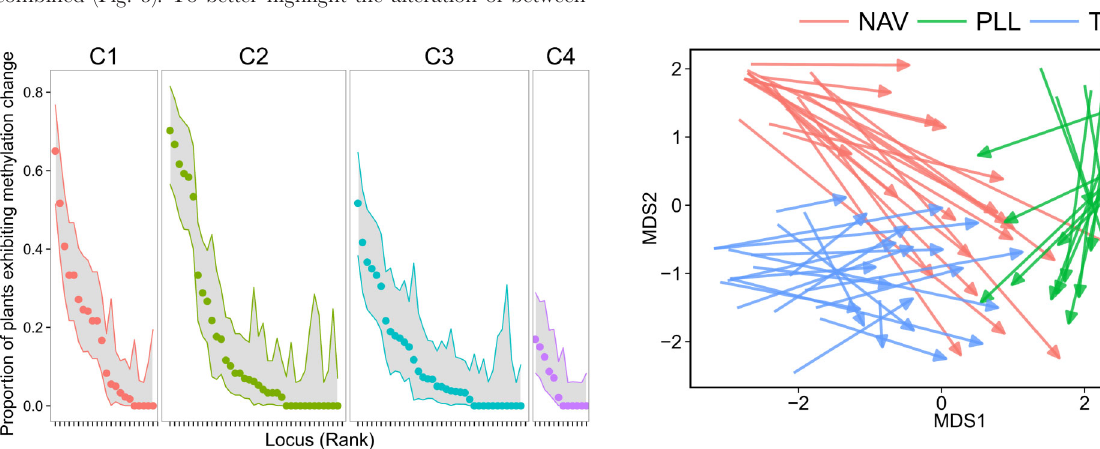
Figure 2. Frequency of DNA methylation changes over the sporophyte-gametophyte transition. Variation among methyla- tion-susceptible loci in degree of instability of methylation status from sporophytes to descendant pollen gametophytes in Helleborus foetidus , expressed as the proportion of individual plants (all sampling sites combined) that exhibited a sporophyte-to-gametophyte methylation change for a given locus. Loci from the four primer combinations used (C1–C4, Table 1) are plotted separately to emphasize the shared pattern. Shaded areas represent the 95% binomial confidence intervals around estimates. Due to missing comparisons (both sporophyte and descendant pollen gametophyte exhibiting uninformative methylation scores), loci differed in number of plants entering the computations, thus the irregularities in width of confidence intervals.